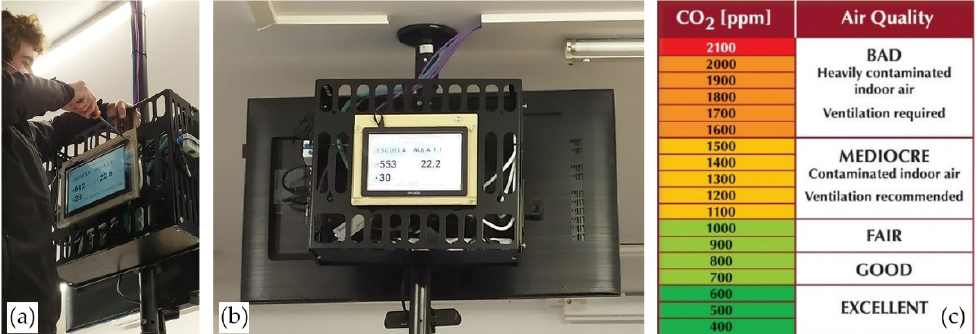
Figure 8. Image ( a ) shows a lesson held in classroom A 1.1 during the winter of 2020–2021, with windows and doors open for cross ventilation. Image ( b ) on the right offers a typical view of the administration office during a workday, with windows partially open. Source: